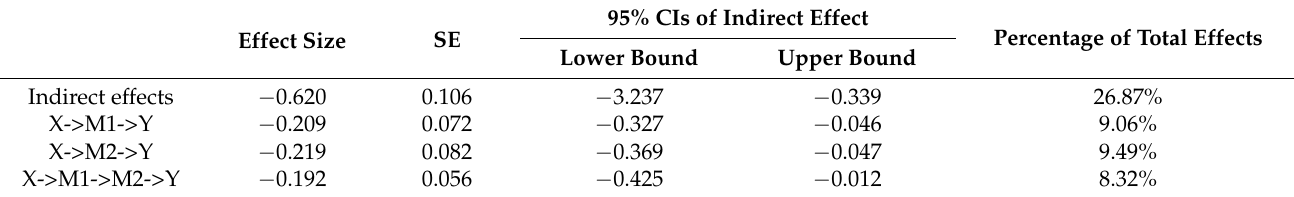
Table 5. Bootstrap analysis of multiple mediation